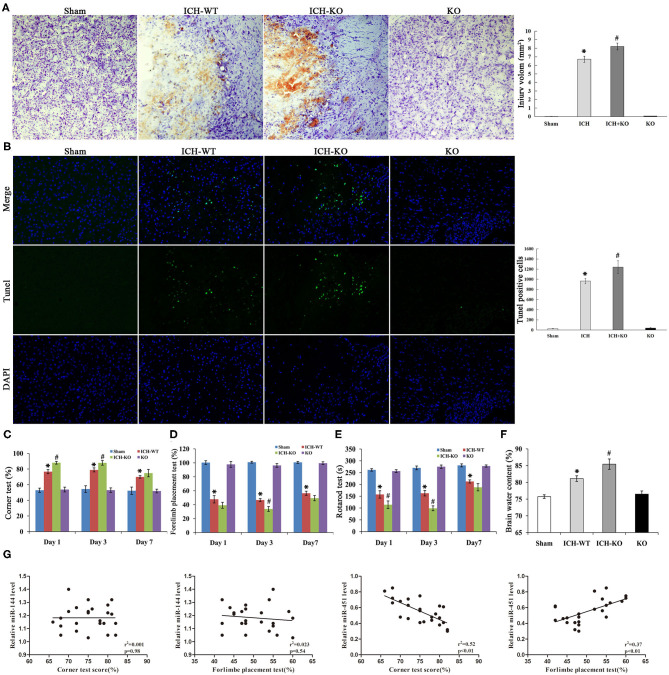
Knockout of miR-144/451 cluster aggravated neurological function and brain injury of ICH mice. (A) Representative Nissl stained images of hematoma area on day 3 after ICH (n = 5). (B) Representative images of TUNEL (green) positive neurons in peri-hematomal area of mice in different groups (n = 5). (C) Corner tests were performed on days 1, 3 and 7 (n = 9). (D) Forelimb placement tests were performed on days 1, 3 and 7 (n = 9). (E) The time on the rod in the rotarod test on days 1, 3 and 7 (n = 9). (F) Brain water content was measured on day 3 after ICH (n = 5). (G) Correlations between miR-144, miR-451 levels and behavior tests using the Pearson correlation test. Data were presented as the mean ± standard deviation. *p < 0.05 vs. the sham group; #p < 0.05 vs. the ICH group. miR, microRNA; ICH, intracerebral hemorrhage; TUNEL, terminal deoxynucleotidyl transferase dUTP nick end labeling.